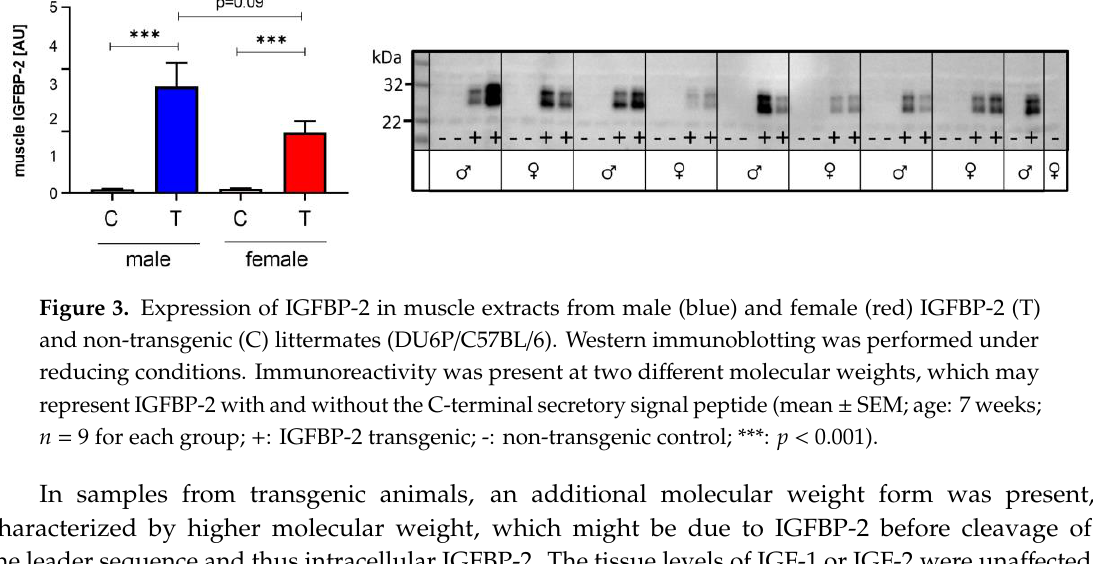
Figure 3 . Expression of IGFBP-2 in muscle extracts from male (blue) and female (red) IGFBP-2 (T) and non-transgenic (C) littermates (DU6P/C57BL/6). Western immunoblotting was performed under reducing conditions. Immunoreactivity was present at two different molecular weights, which may represent IGFBP-2 with and without the C-terminal secretory signal peptide (mean ± SEM; age: 7 weeks; n = 9 for each group; +: IGFBP-2 transgenic; -: non-transgenic control; ***: p < 0.001).